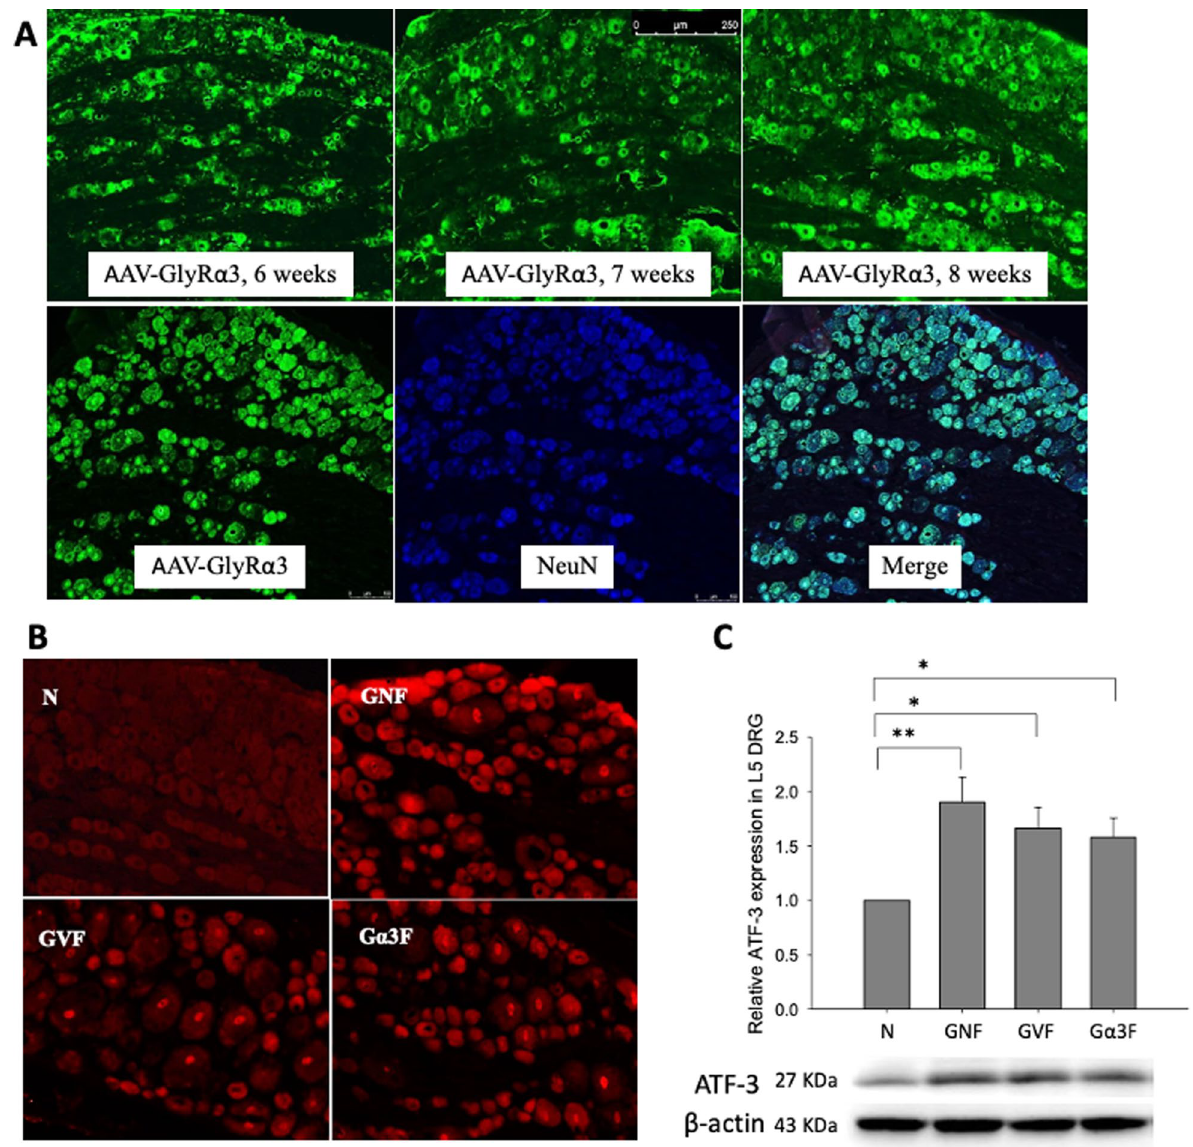
Fig. 3 Immunofluorescence images of AAV‑GlyRα3, and ATF‑3 expression in the DRG. A Expression of green fluorescent protein (GFP) in L5 DRGs was detected by immunofluorescence six to eight weeks after intrathecal AAV‑GlyRα3 (2.5 10 12 vg) injection. Double immunofluorescence × staining showing GlyRα3 and NeuN co‑localization in the L5 DRG. Positive for GlyRα3 are shown in green, positive for NeuN are shown in blue, merge images of GlyRα3 and neuron are indicated in peacock blue. A injury assessment by ATF‑3 expression of DRG tissue sections from CFA (100 μl) subcutaneous hind paw injection. Group intrathecal NaCl plus CFA injection (GNF), group intrathecal AAV (2.5 10 12 vg) plus CFA injection × (GVF), and group intrathecal AAV‑GlyRα3 (2.5 10 12 vg) plus CFA injection (Gα3F) are compared. ATF‑3 expression in the DRG was measured by × B immunofluorescence and C western blotting. The data represent the means SE (n 6–9 per group). One‑way ANOVA. * p < 0.05, ** p < 0.01, ± = *** p < 0.001. ATF‑3 indicates activating transcription factor; scale bars: 250